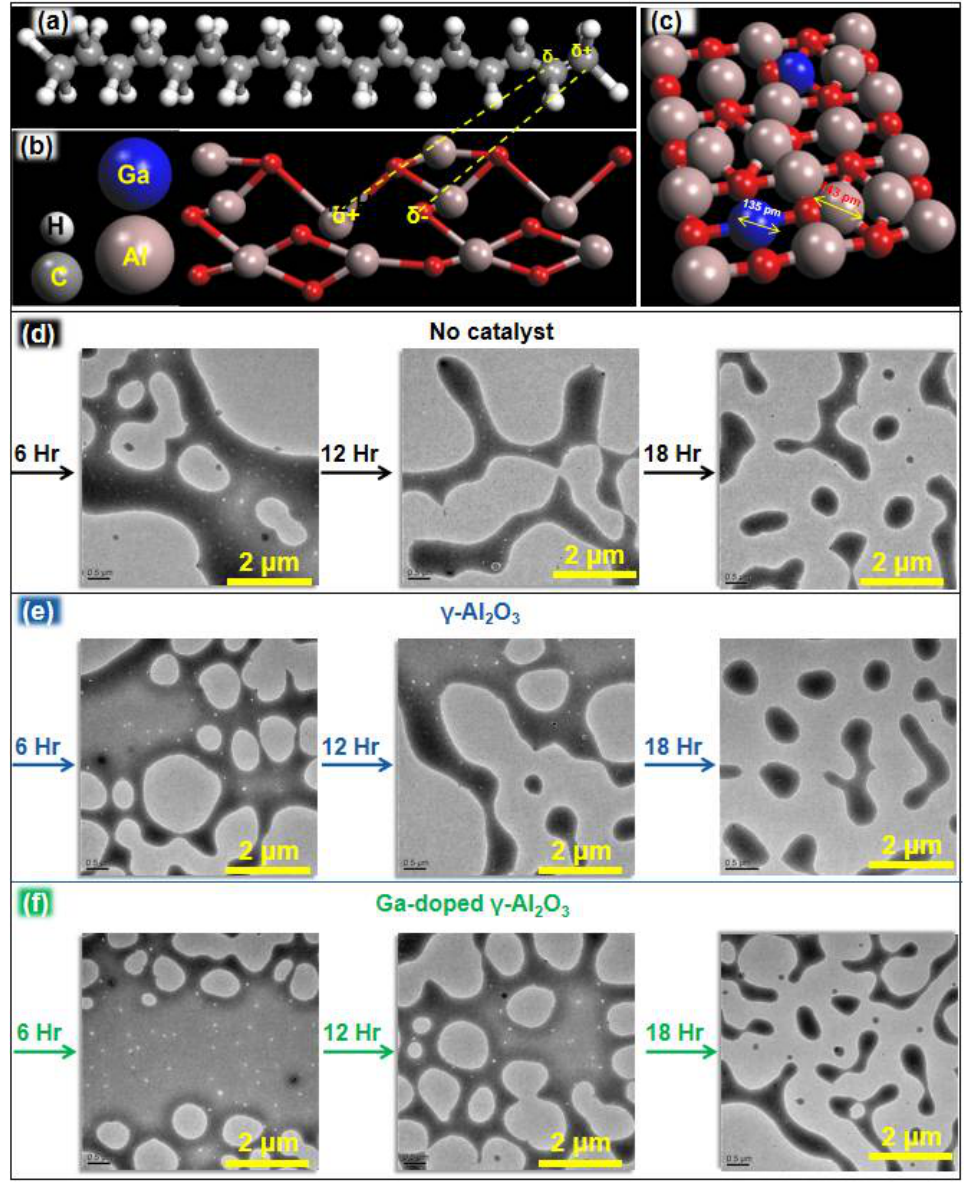
Figure 5. ( a ) 1-octadecene, ( b ) attachment of 1-octadecene on γ-Al 2 O 3 (100) and ( c ) general represen- tation of Ga-substituted γ-Al 2 O 3 . TEM images of PE particles at different time intervals when the degradation process was performed ( d ) without catalyst, ( e ) with γ-Al 2 O 3 and ( f ) with Ga-doped γ- Al 2 O